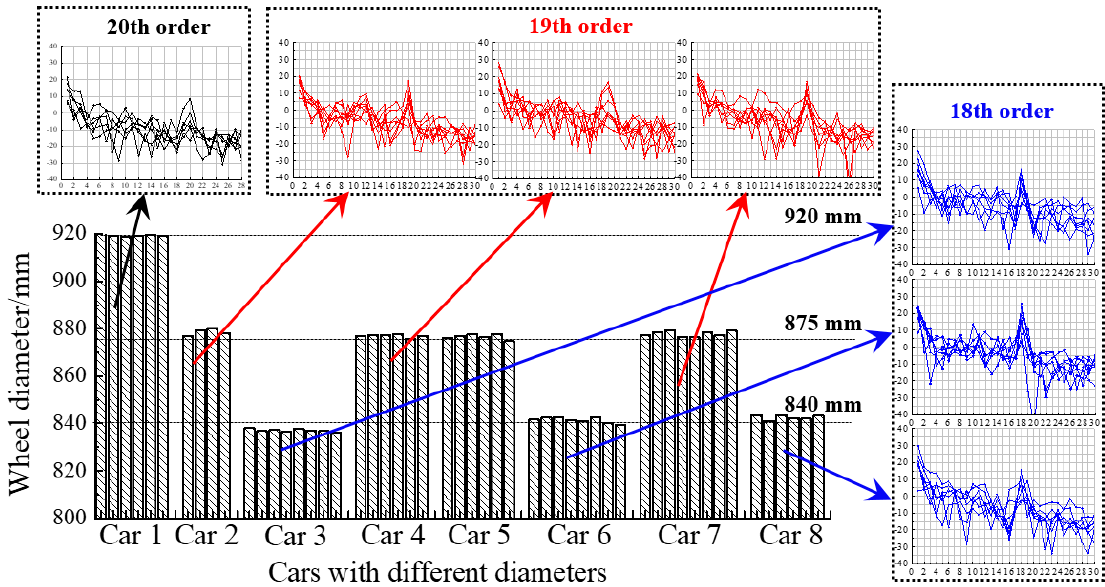
Figure 5. Polygonal wear of different orders corresponding to different wheel diameters.